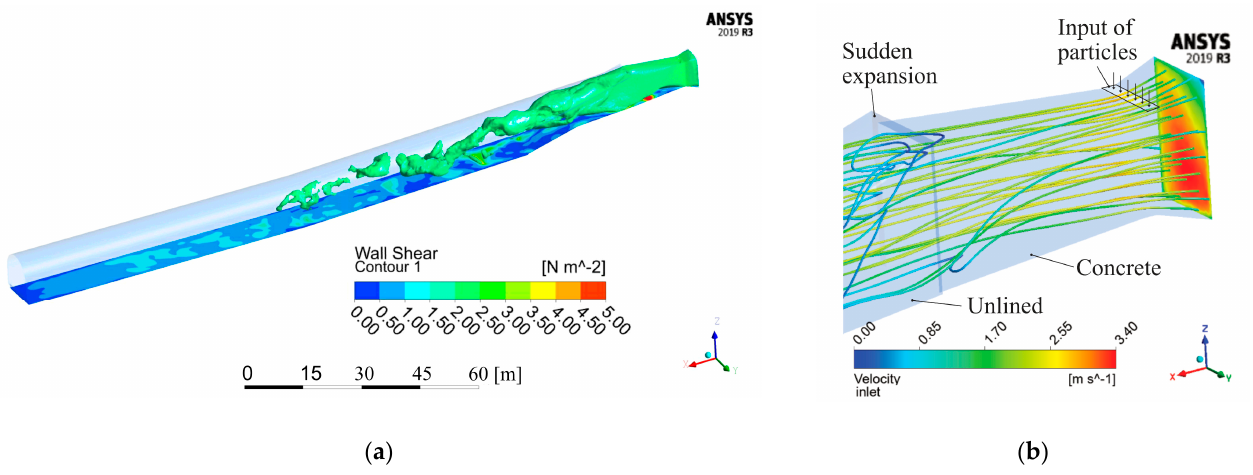
Figure 6. Transient simulation of the pressurized sand trap with focus on the inlet jet. The inlet flow boundary condition is from a separate approach flow simulation presented earlier. ( a ) Bottom shear stress and isosurface of 1 m/s (1.49 * average sand trap velocity) for inlet discharge 80 m³/s. ( b ) Inlet boundary flow conditions, illustrating the transition from the concrete lined section to unlined section, resulting in a sudden expansion. This figure also shows the input section of particles (next chapter).